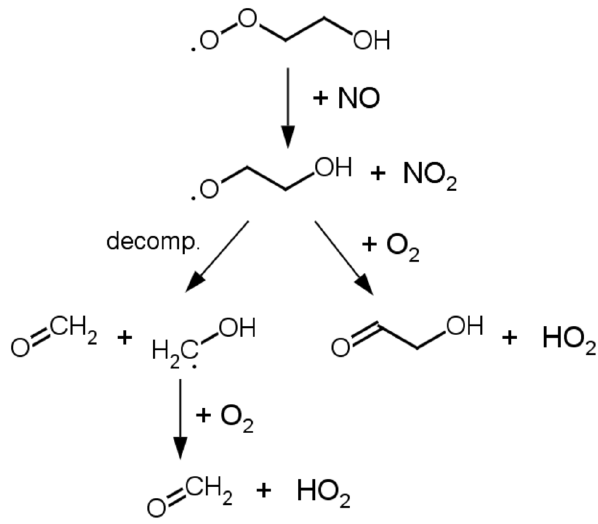
Fig. 8. Reaction scheme of the radical sequence of the β - hydroxyalkyl peroxy radical produced by the reaction of OH with ethene. The β -hydroxyalkoxy radical formed in the reaction with NO either decomposes or reacts with O 2 in contrast to other β - hydroxyalkoxy species which exclusively